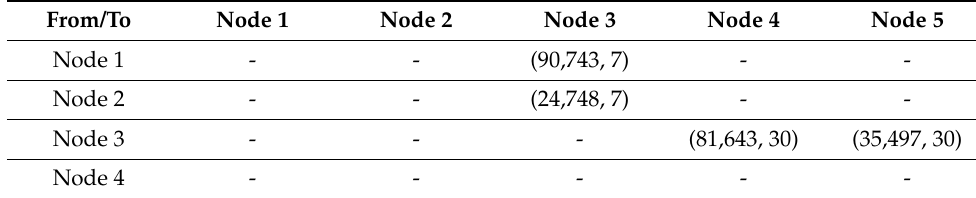
Table 10. Ordering behavior of nodes in Topology 2.